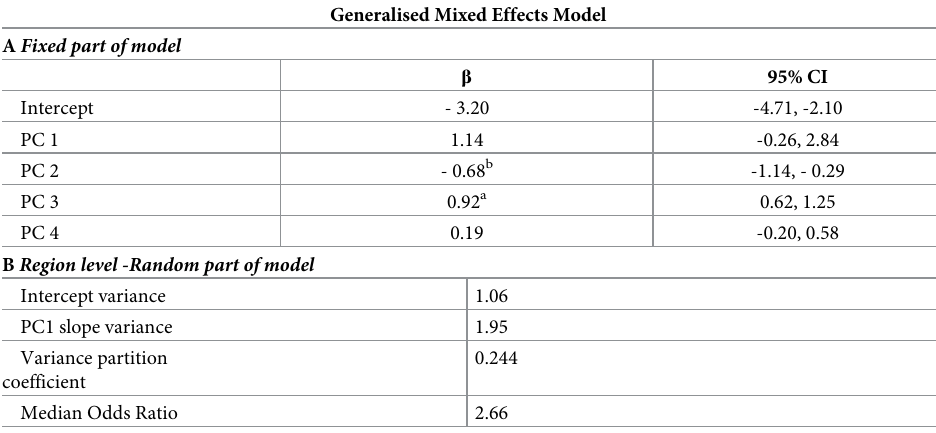
Table 3. Multi-level analysis of association between principal components and consistently high HIV prevalence in Indian districts: 2007–12.